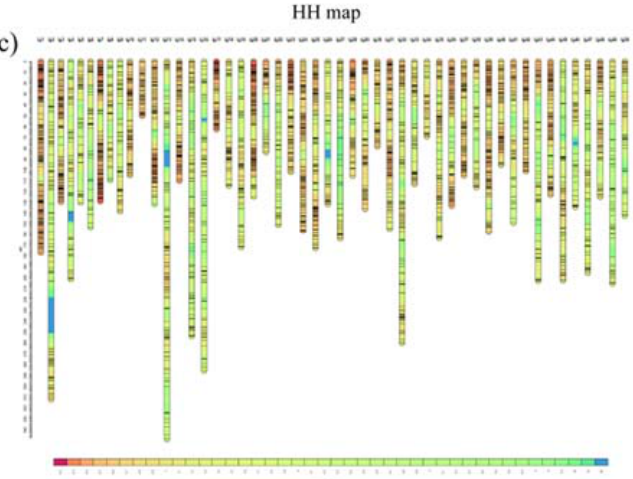
Figure 1. High-density genetic linkage maps of maternal ( a ), paternal ( b ), and HH ( c ) Yellow River carp.